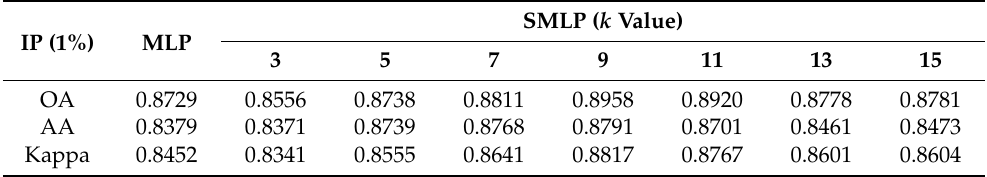
Table 4. Performance of the SMLP structure with different k value on the IP dataset